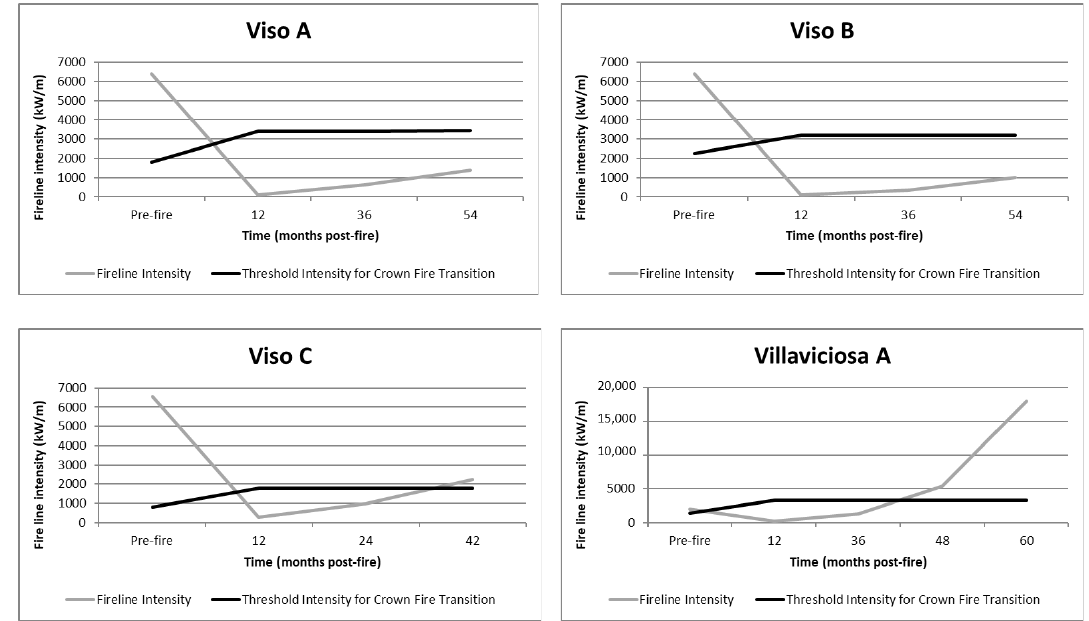
Figure 5. Fire-line intensity versus threshold intensity for crown fire transition in Groups A (Viso A, Viso B, Viso C) and C (Villaviciosa A). If the fire intensity is higher than threshold intensity, surface fire will be sufficient to ignite tree crowns.